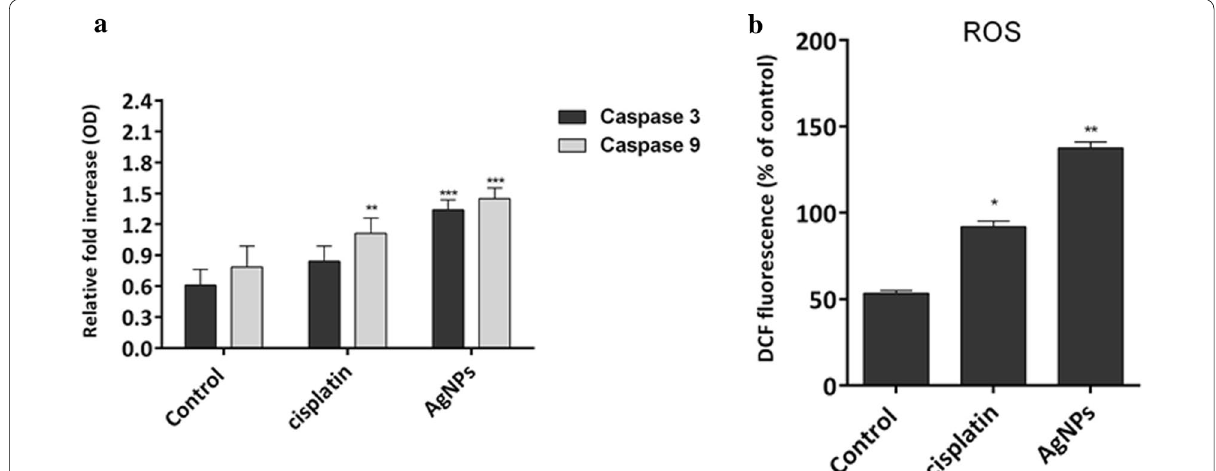
Fig. 9 Effect of silver nanoparticles and cisplatin on caspases ( a ) and ROS production ( b ) in A549 lung carcinoma cell line. Each bar represents the mean SD of three independent observations. *P < 0.05 and **P < 0.01 are considered statistically significant ±